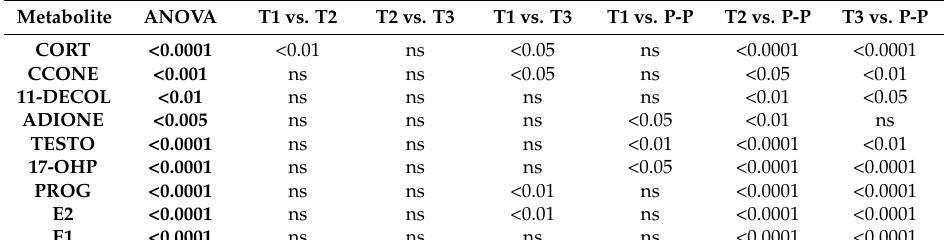
Table 2. Observed differences, in terms of p -value as well as not significant (ns) p -value, in each time comparison for steroids and estrogens quantified by Liquid Chromatography Tandem Mass Spectrometry (LC-MS/MS) analyses. First Trimester versus Second Trimester: T1 vs. T2; Second Trimester versus Third Trimester: T2 vs. T3; First Trimester versus Third Trimester: T1 vs. T3; First Trimester versus Post-Partum: T1 vs. P-P; Second Trimester versus Post-Partum: T2 vs. P-P; Third